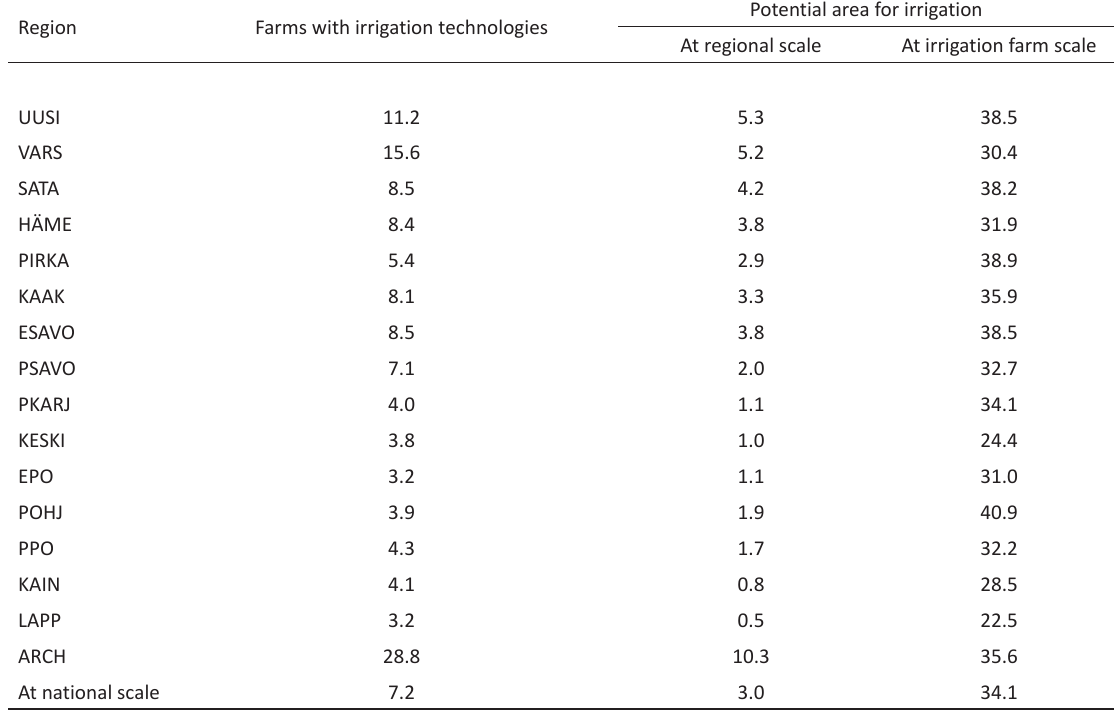
Table 2. Regional differences in proportion of farms with irrigation technologies (%) and proportion of arable land available for irrigation (%) in 2010. Regions: UUSI, Uusimaa; VARS, Vasinais-Suomi; SATA, Satakunta; HÄME, Häme; PIRKA, Pirkanmaa; KAAK, Kaakkois-Suomi; ESAVO, Etelä-Savo; PSAVO, Pohjois-Savo; PKARJ, Pohjois-Karjala; KESKI, Keski-Suomi; EPO, Etelä-Pohjanmaa; POHJ, Pohjanmaa; PPO, Pohjois-Pohjanmaa; KAIN, Kainuu; LAPP, Lapplan; ARCH, Archipelago. See regions in map in Figure 1. Data from Tike (2012).